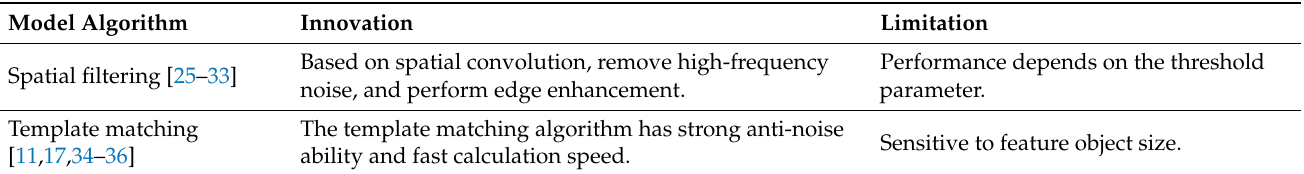
5 of 18 Table 1. Comparison of image processing algorithms. Model Algorithm